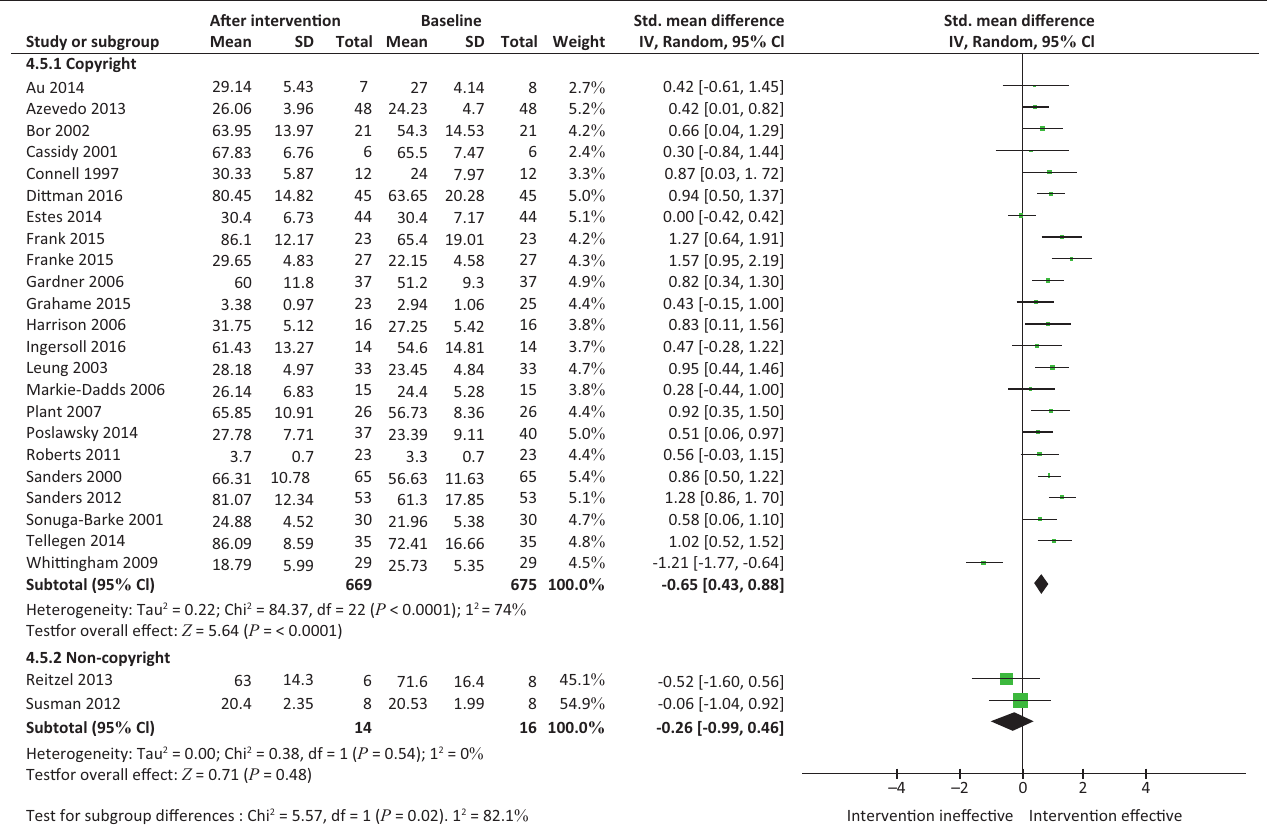
FIGURE 5: Random effects meta-analysis of the summative effects of parent training programmes according to programme type.